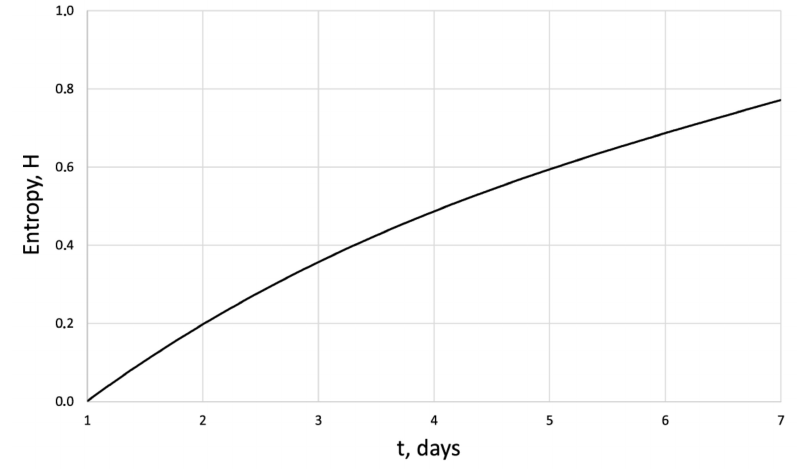
Figure 7. Entropy of the human dermal fibroblasts under pulsed electromagnetic influence E = 500